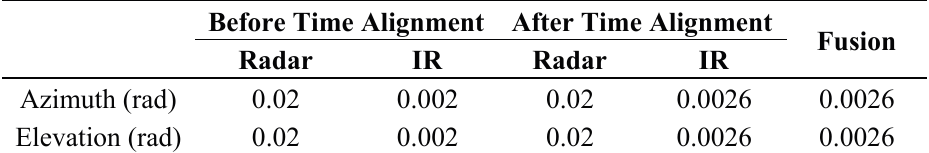
Table 1. Standard deviation comparison.